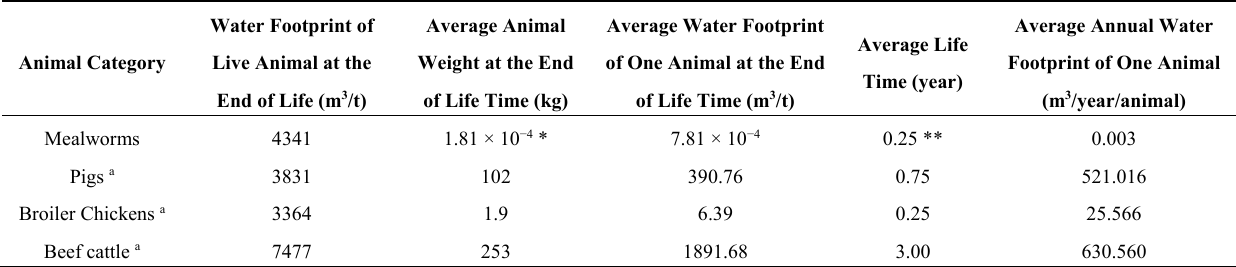
Table 5. Average annual water footprint of a single animal per animal category.